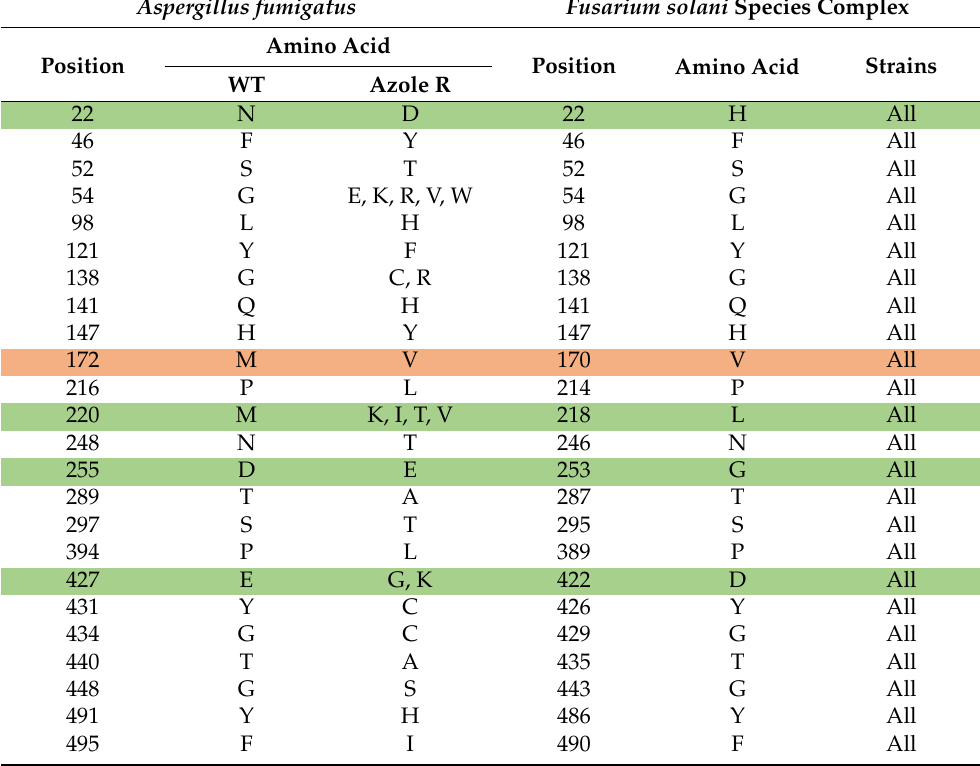
Table 6. Comparison of amino acid changes observed in our FSSC strains with those associated with azole resistance in A. fumigatus CYP51A (green: point mutations different from wild-type (WT) and mutated (azole R) A. fumigatus ; orange: point mutation different from WT A. fumigatus but identical to resistant A. fumigatus (azole